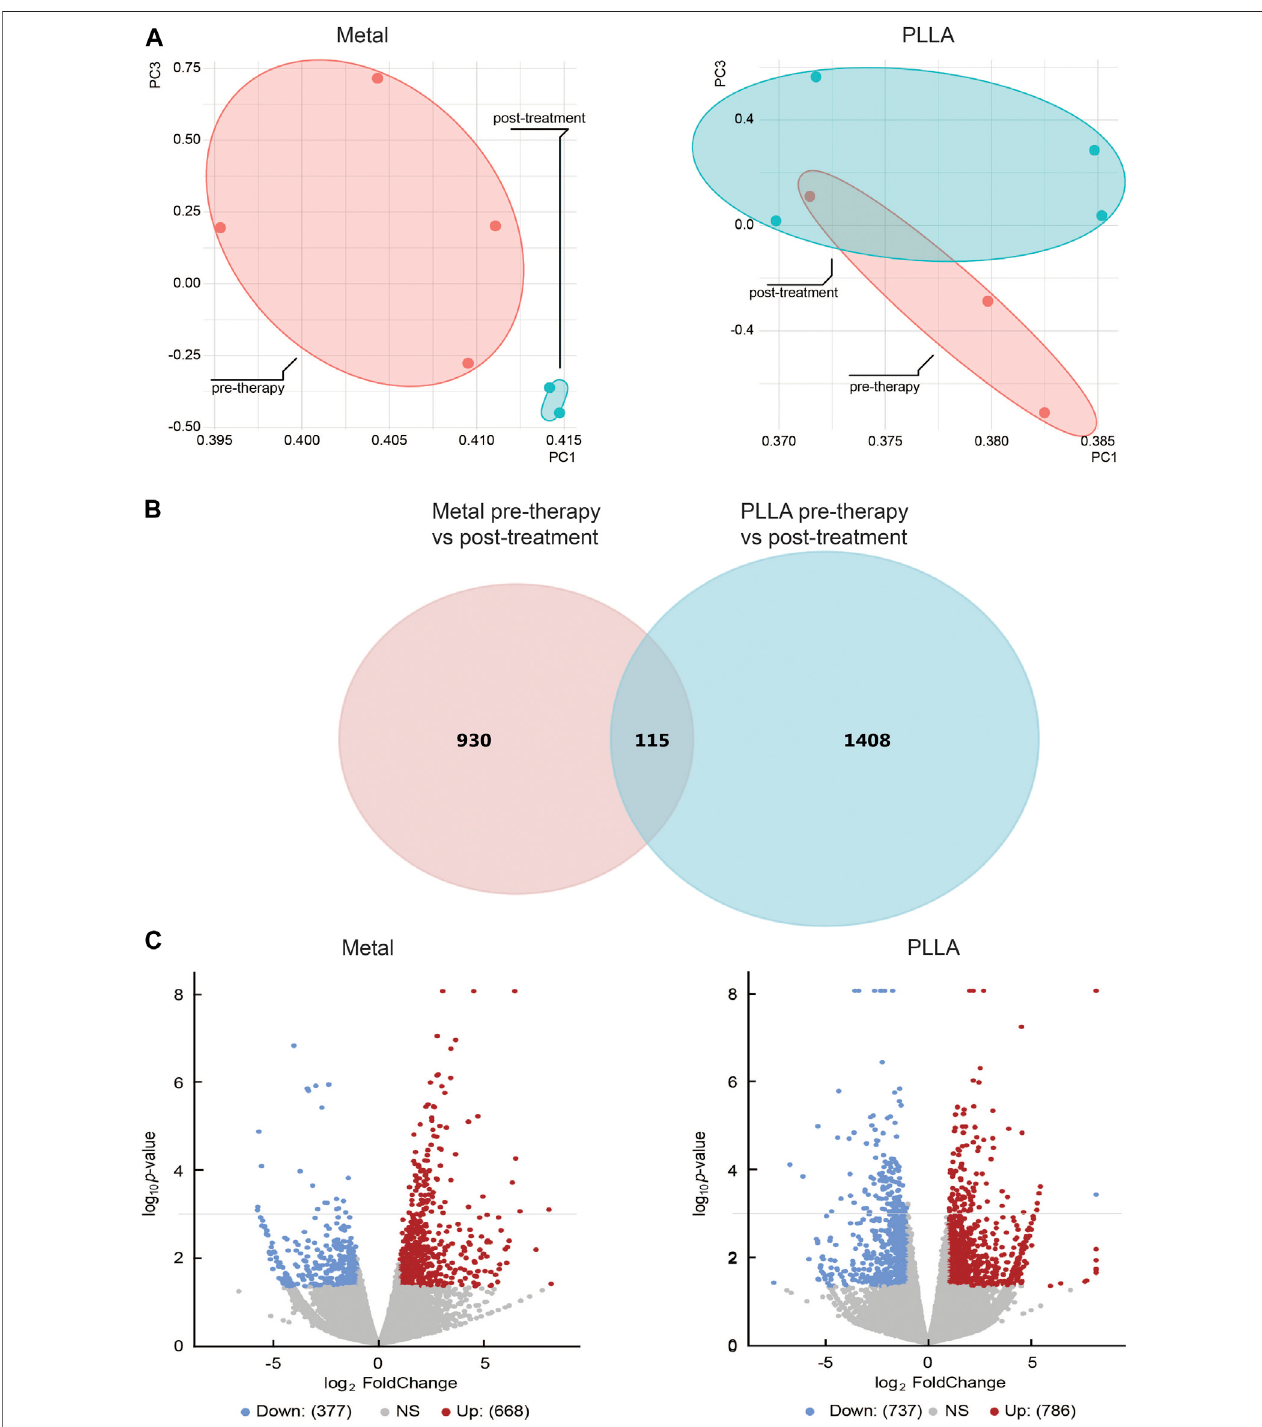
FIGURE 1 | The differential expression genes (DEGs) analysis of atrial septal defects patients before and after metal and PLLA device therapy. (A) Samples can be distinguishedbyprincipalcomponentanalysis(PCA). (B) Venndiagram showing thegenesidenti fi edin PLLAand metal deviceafter and beforetherapy. (C) Signi fi cantly changedgeneswerediscoveredfromdifferentiallyexpressionanalysis.Genewitha p -valuelessthan0.05andanabsolutefoldchangegreaterthan2isconsideredasa signi fi cantly changed gene. In each panel, the blue dots represented downregulated genes and the red dots represented upregulated genes.